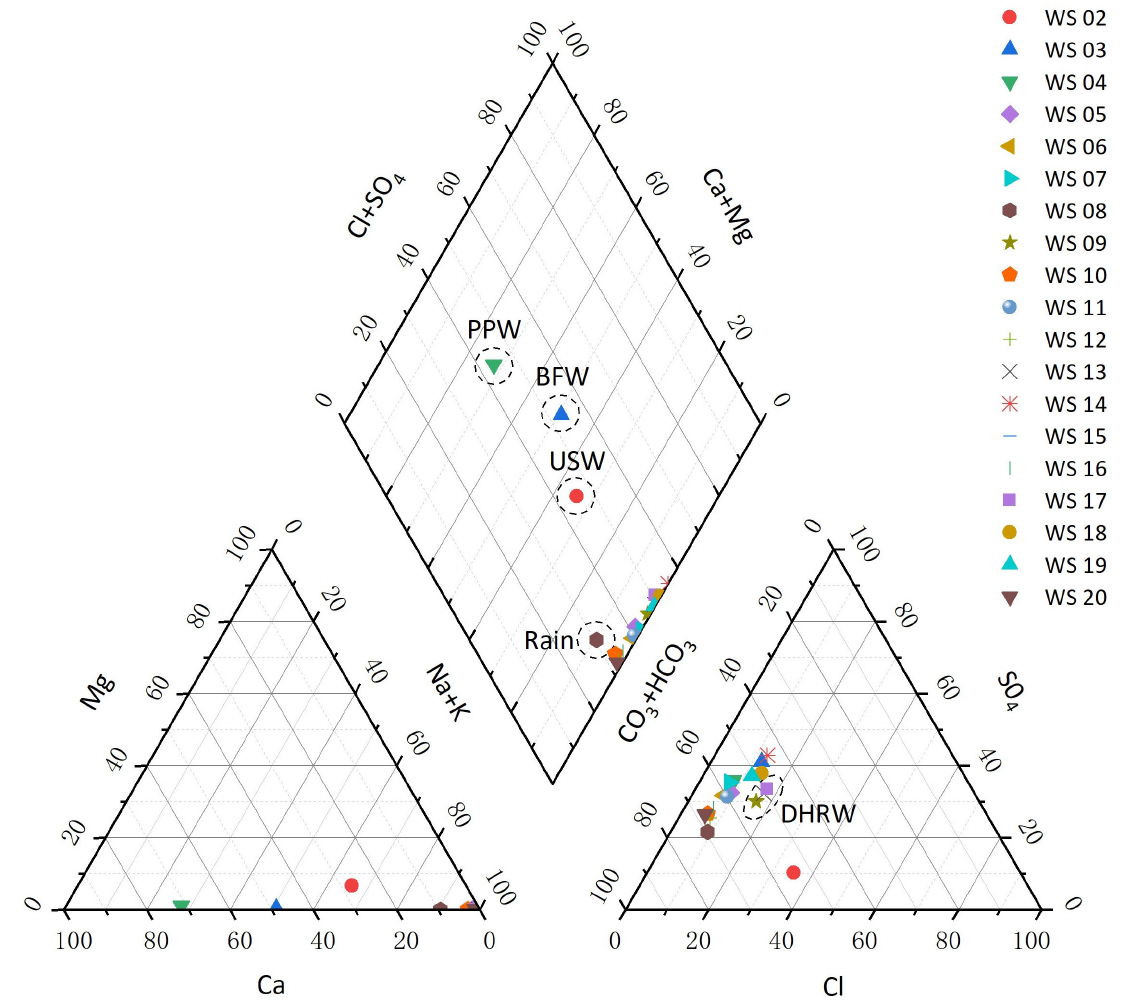
Figure 14. Piper diagram of 19 water